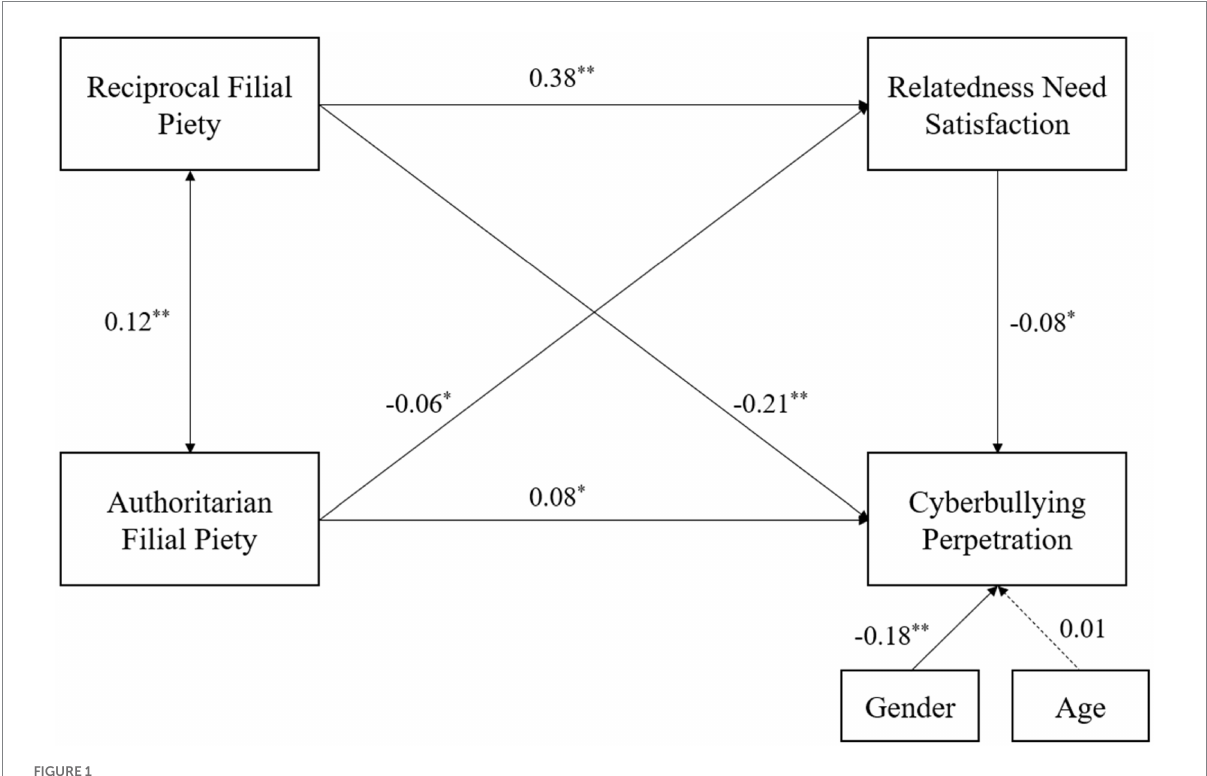
FIGURE 1 Structural model. * p < 0.05, ** p <